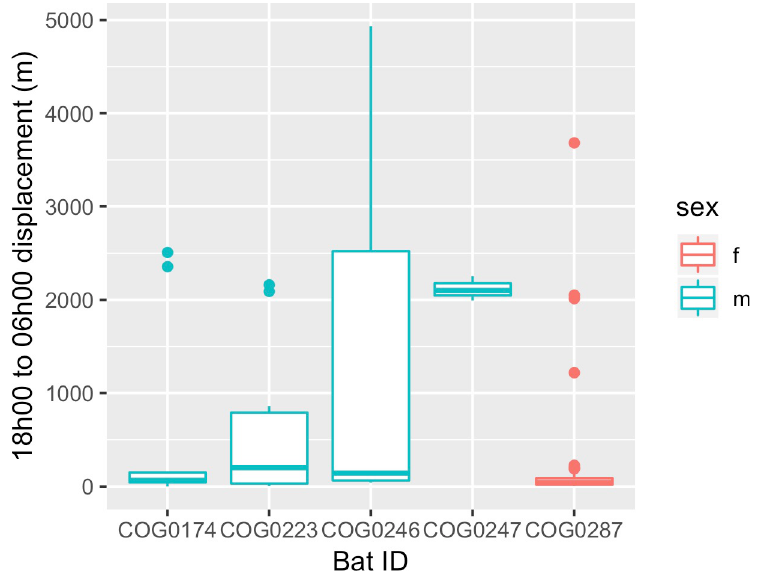
Fig 3. Day roost fidelity. Tukey box and whiskers plot of nightly overall displacement patterns (m) by each bat as measured from where the bat began the evening (typically around 18h00 WAT) and arrived in the following morning (typically around 06h00